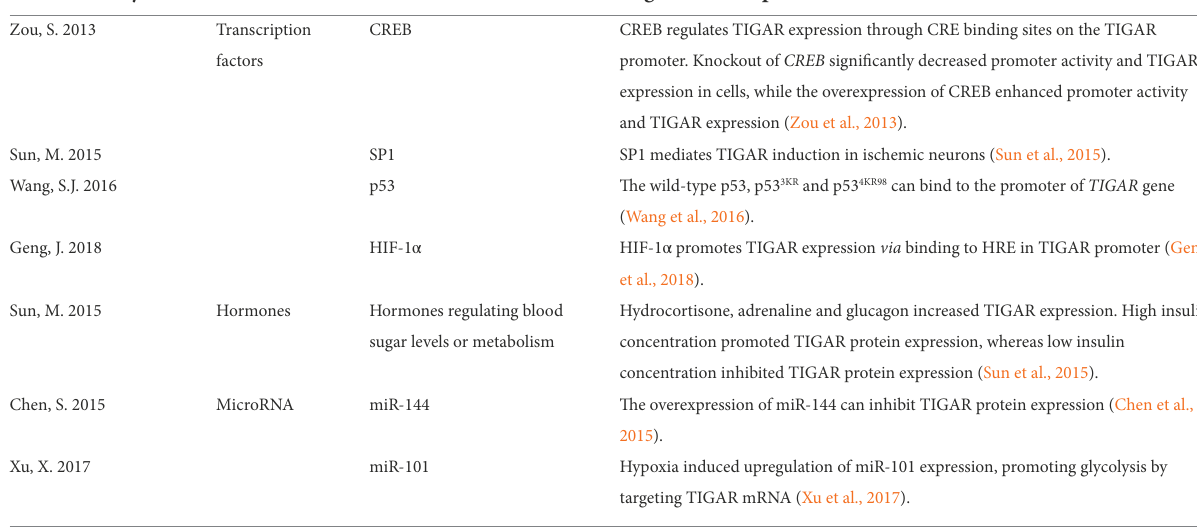
TABLE 1 Factors regulating the expression of